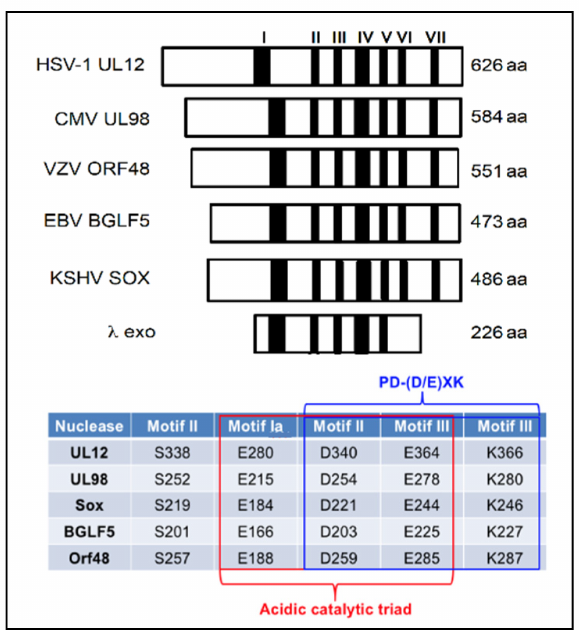
Figure 2. The seven conserved motifs of the herpesvirus alkaline nucleases as well as active site residues are shown. S = serine, E = glutamic acid, D = aspartic acid, K = lysine.